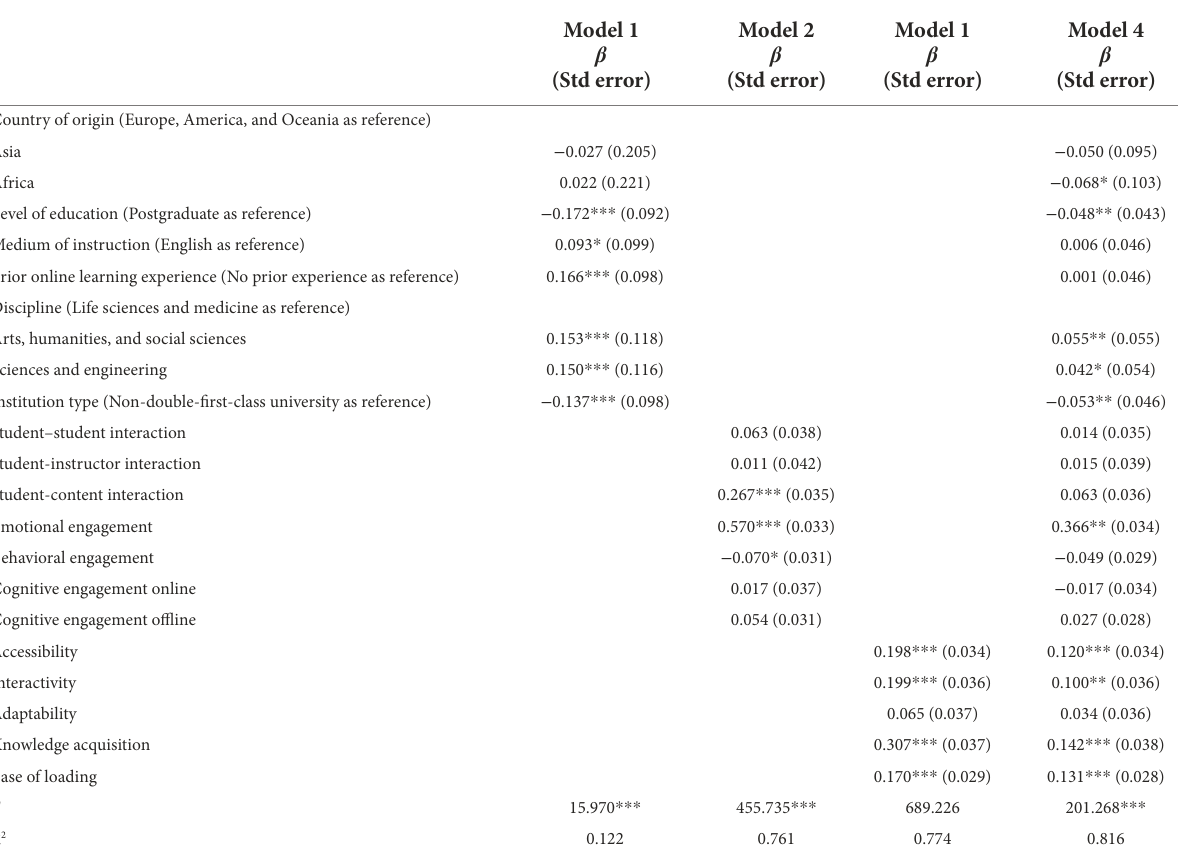
TABLE 7 Factors associated with online learning